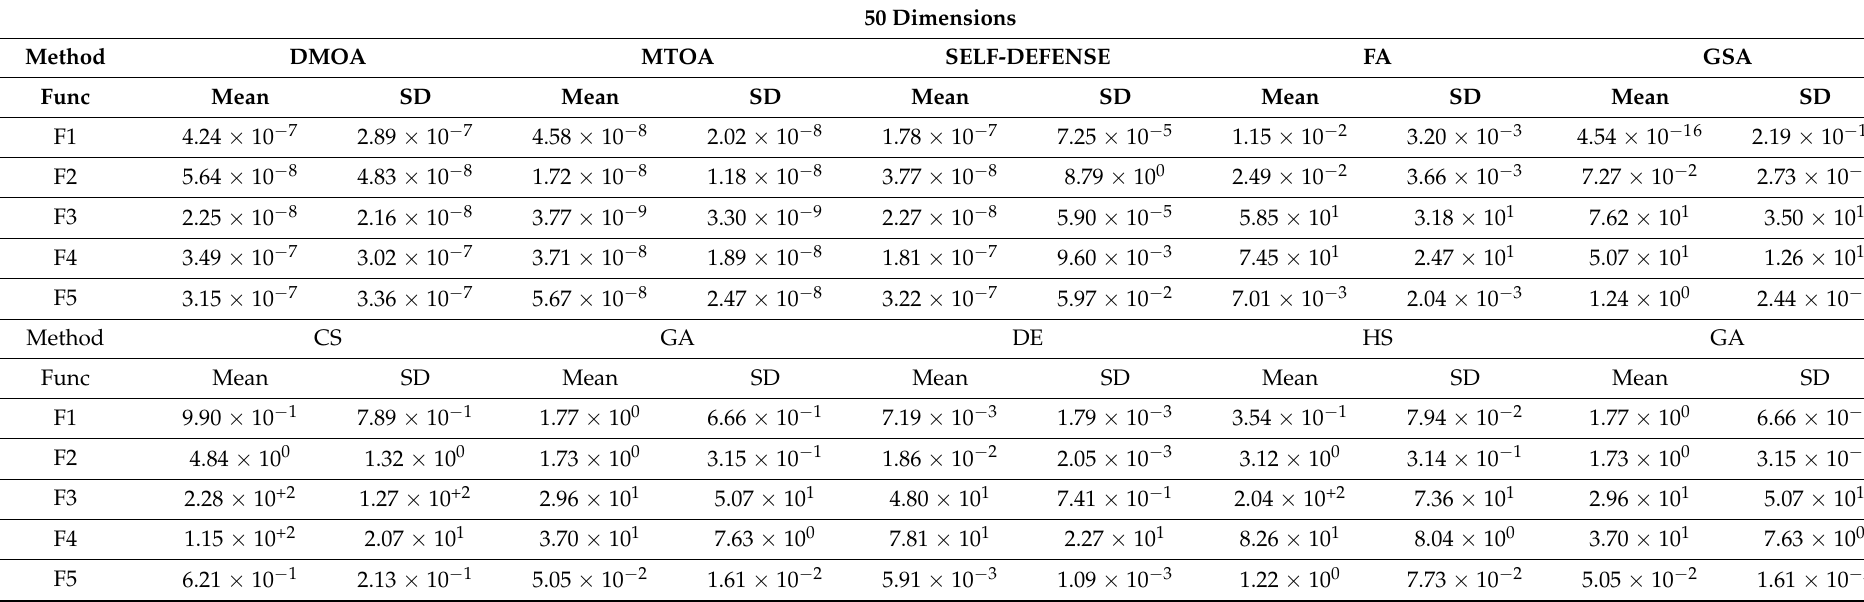
Table 14. Comparison of the Mean and Standard Deviation of the DMOA Algorithm with other methods, for 50 dimensions. 50